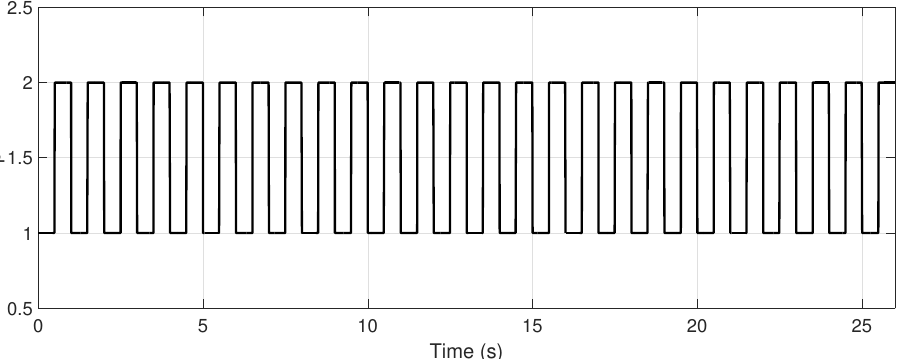
Figure 4. Designed switching law.